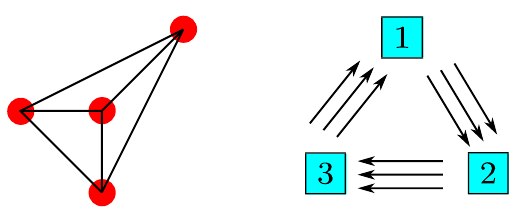
Figure 8. Toric diagram (left) and quiver diagram (right) of K P 2 geometry. The number of arrows between two vertices of the quiver diagram is not